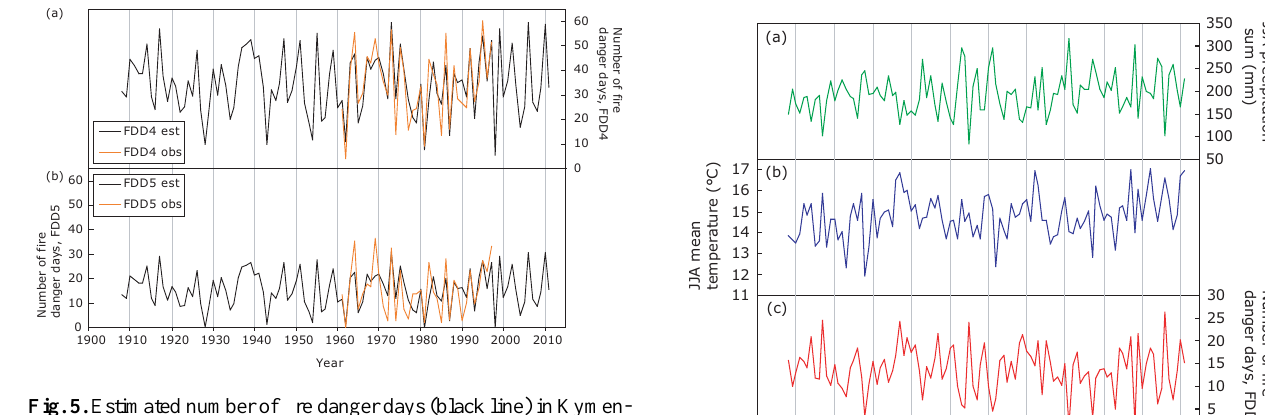
Fig. 5. Estimated number of fire danger days (black line) in Kymen- laakso (a) FDD4 and (b) FDD5 in 1908–2011. Red line shows the calculated number of the fire danger days based on the FFI data in 1961–1997.